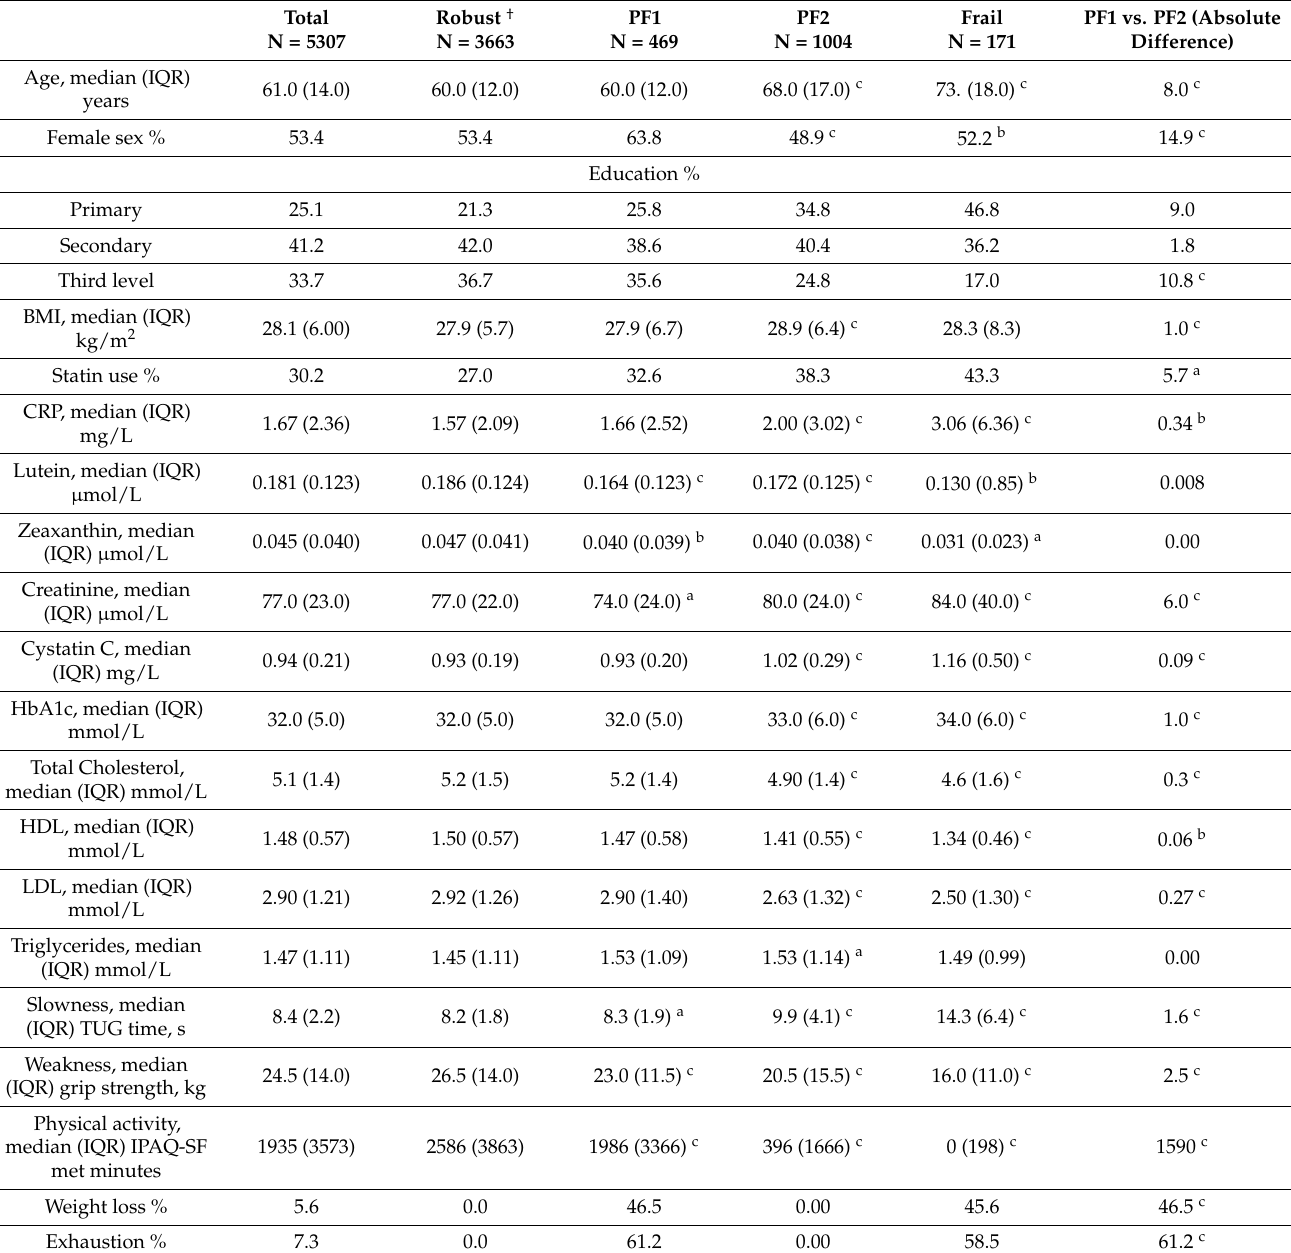
Table 2. Associations between frailty groups and characteristics of